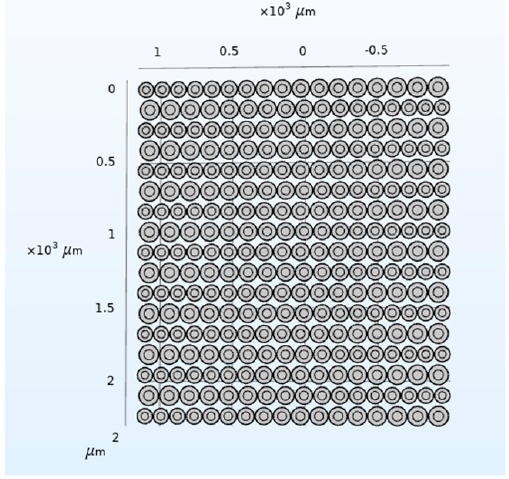
Figure 20. CMUT structure in waters.